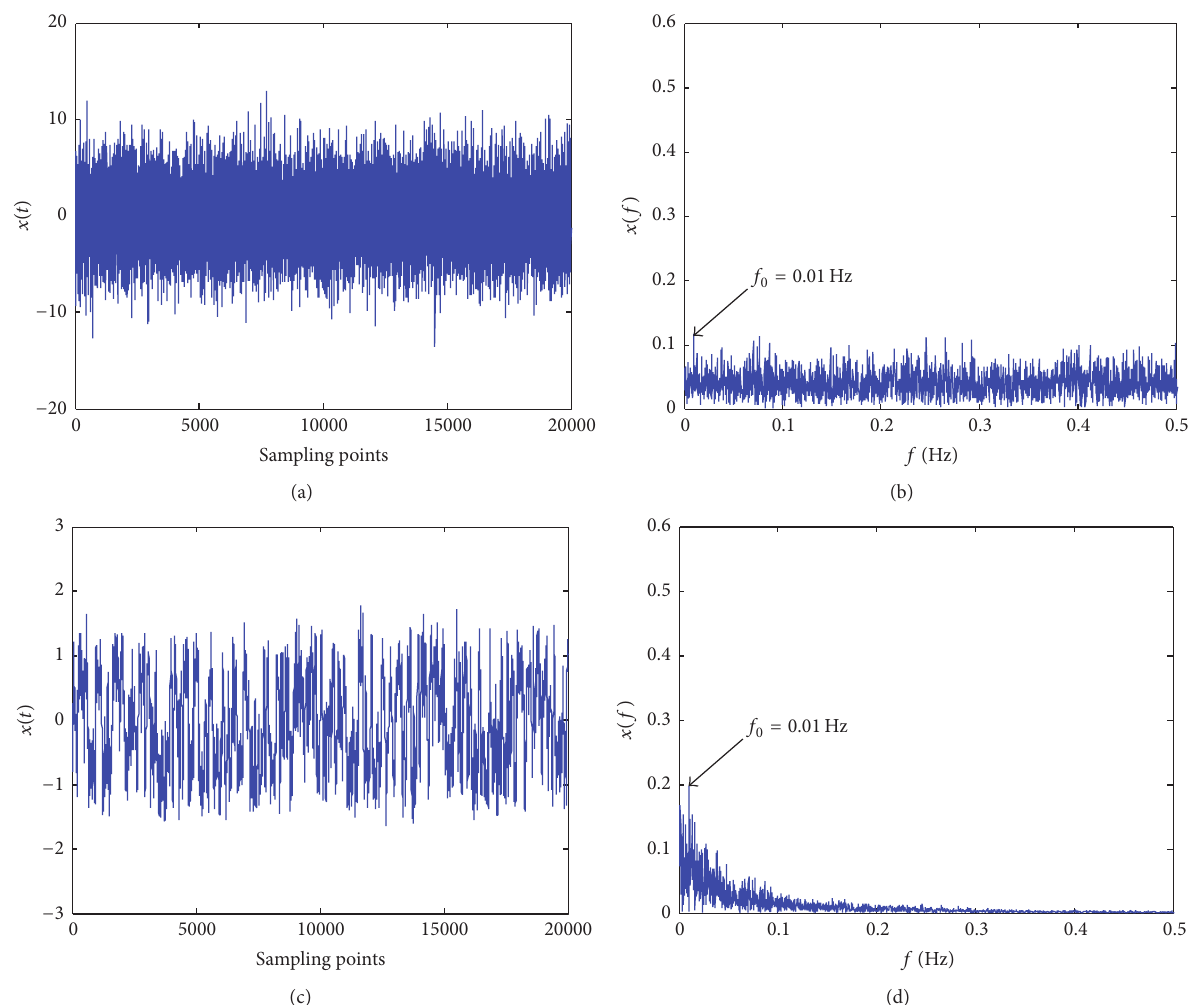
Figure 4: Phenomenon of system SR under the noise intensity 𝐷 = 5 . (a) Time-domain waveform of input signals, (b) frequency spectrum of input signals, (c) time-domain waveform of output signals, and (d) frequency spectrum of output